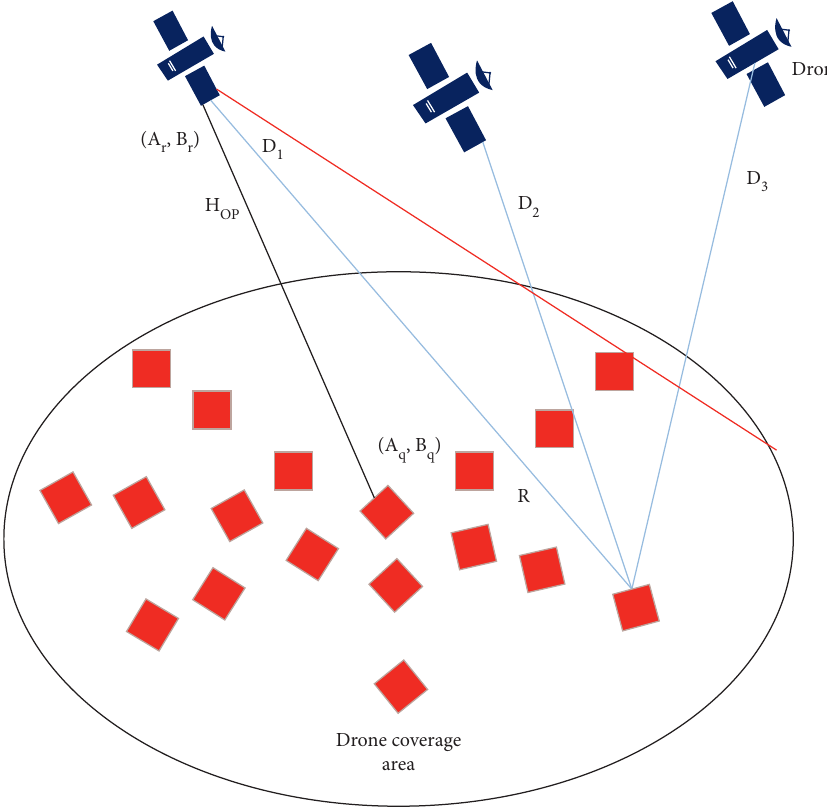
Figure 5: Drone into IoT